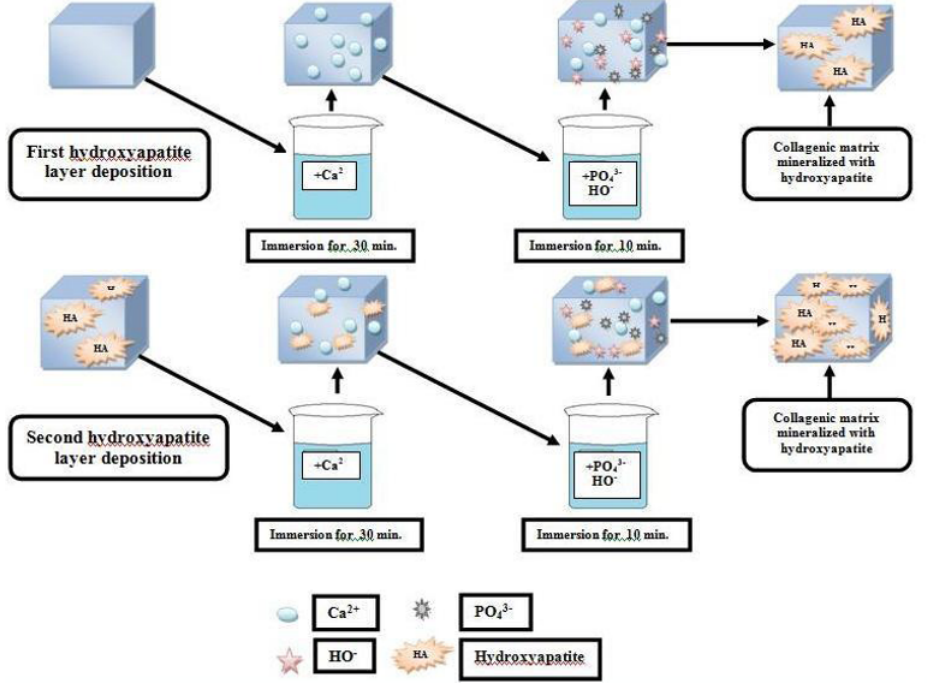
Figure 1. Schematic representation of LbL deposition of HA into the collagen